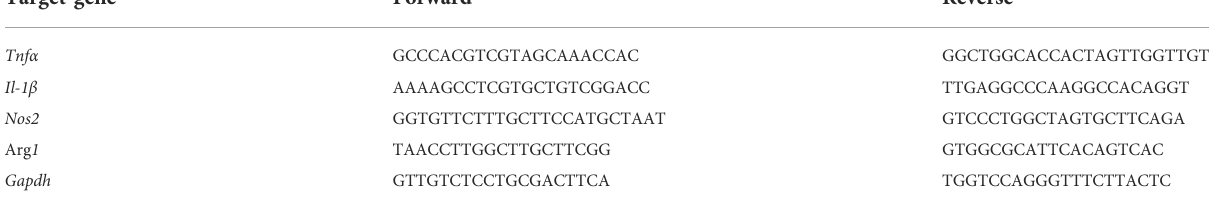
TABLE 2 List of primer pairs for real-time